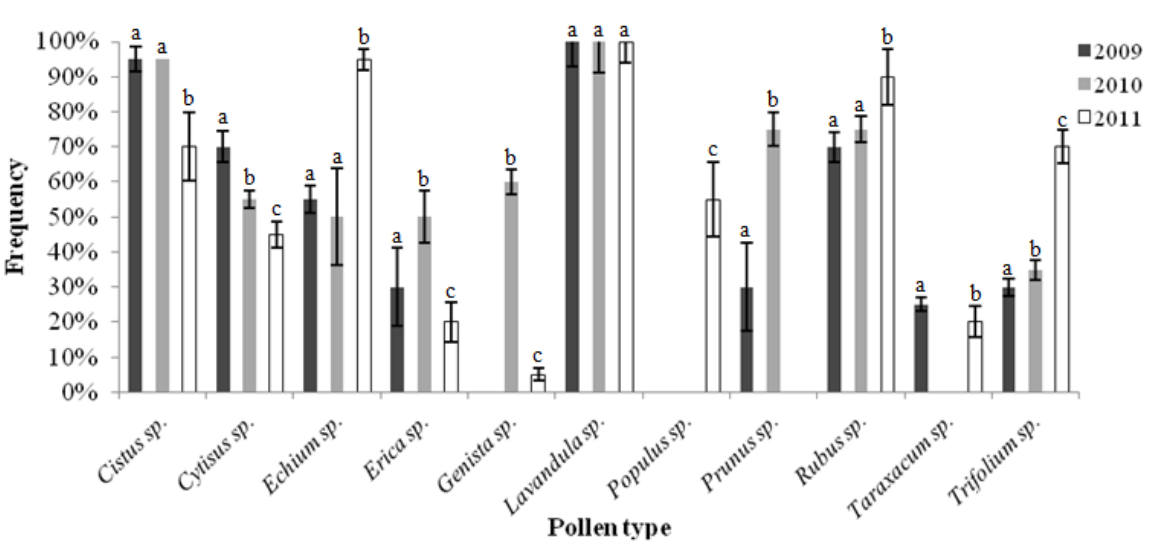
Figure 1. Polinic spectrum of the “Terra Quente” honeys from the three harvests. The letters (a,b,c) represents which honeys are different by Tukey test with significance of α =